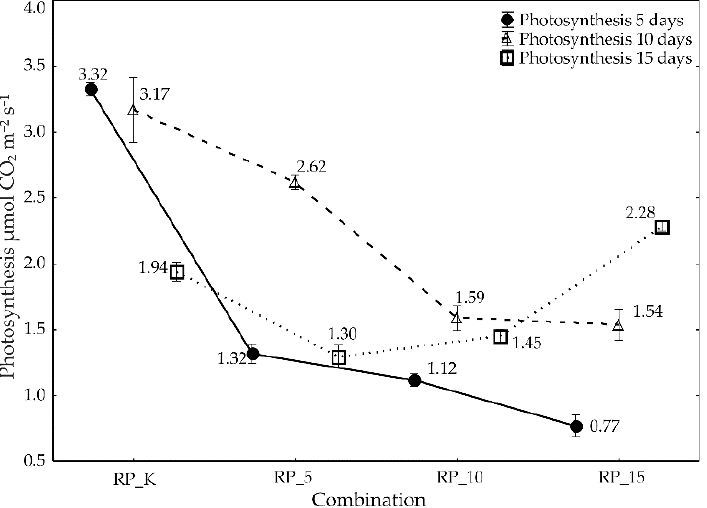
Figure 2. Intensity of photosynthesis at the set time intervals in winter wheat with different numbers of foraging aphids of R . padi . Vertical lines at mean values indicate SE.